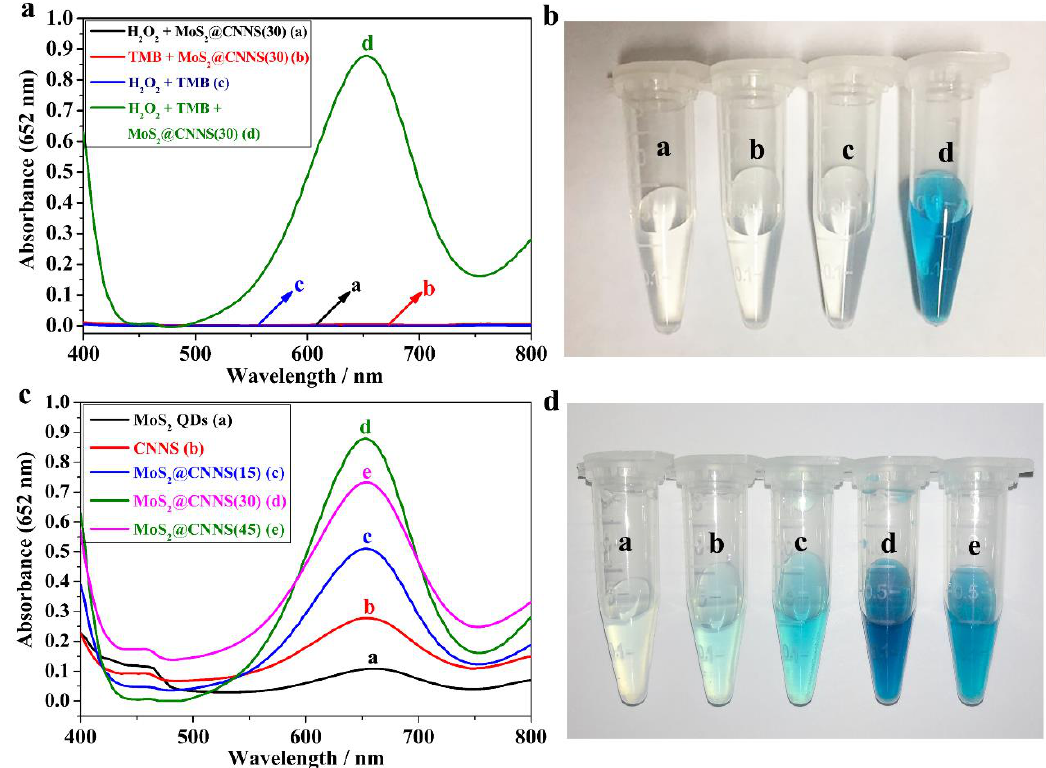
Figure 3. UV-visible absorption spectra ( a ) and color changes ( b ) of different reaction systems (a. H 2 O 2 + MoS 2 @CNNS(30), b. TMB + MoS 2 @CNNS(30), c. H 2 O 2 + TMB, and d. H 2 O 2 + TMB + MoS 2 @CNNS(30); UV-visible absorption spectra ( c ) and color changes ( d ) in the presence of different MoS 2 @CNNS nanocomposites.